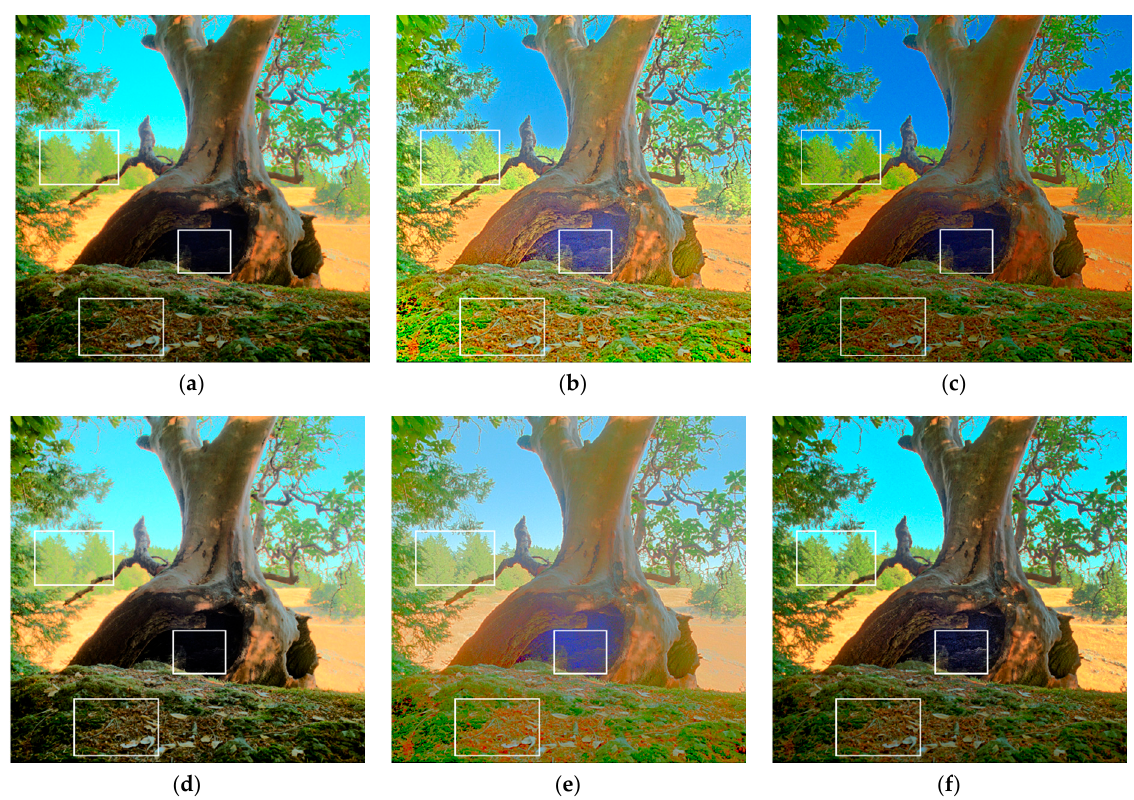
Figure 9. Results of the test image Cadik_Desk02 by ( a ) Khan et al. [9], ( b ) Gu et al. [11], ( c ) Gao et al. [28], ( d ) Ok et al. [23], ( e ) Yang et al. [21], and ( f ) the proposed method. The white rectangles indicate the areas which should be closely examined by the reader.